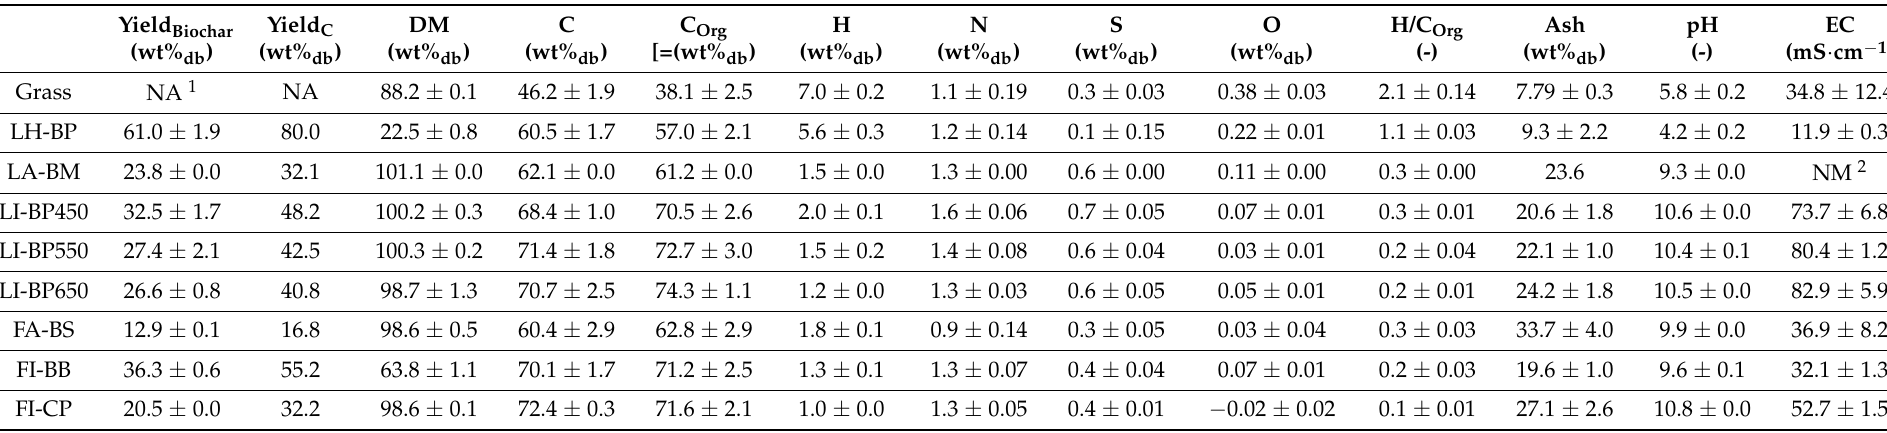
Table 2. Biochar and carbon yield of the process and phyisco-chemical characteristics of feedstock and biochar (ultimate analysis, dry matter content (DM), organic carbon (C Org ), H/C Org ratio, ash content pH and electrical conductivity (EC)). For all parameters the mean values and standard deviation are presented ( n = 3), if